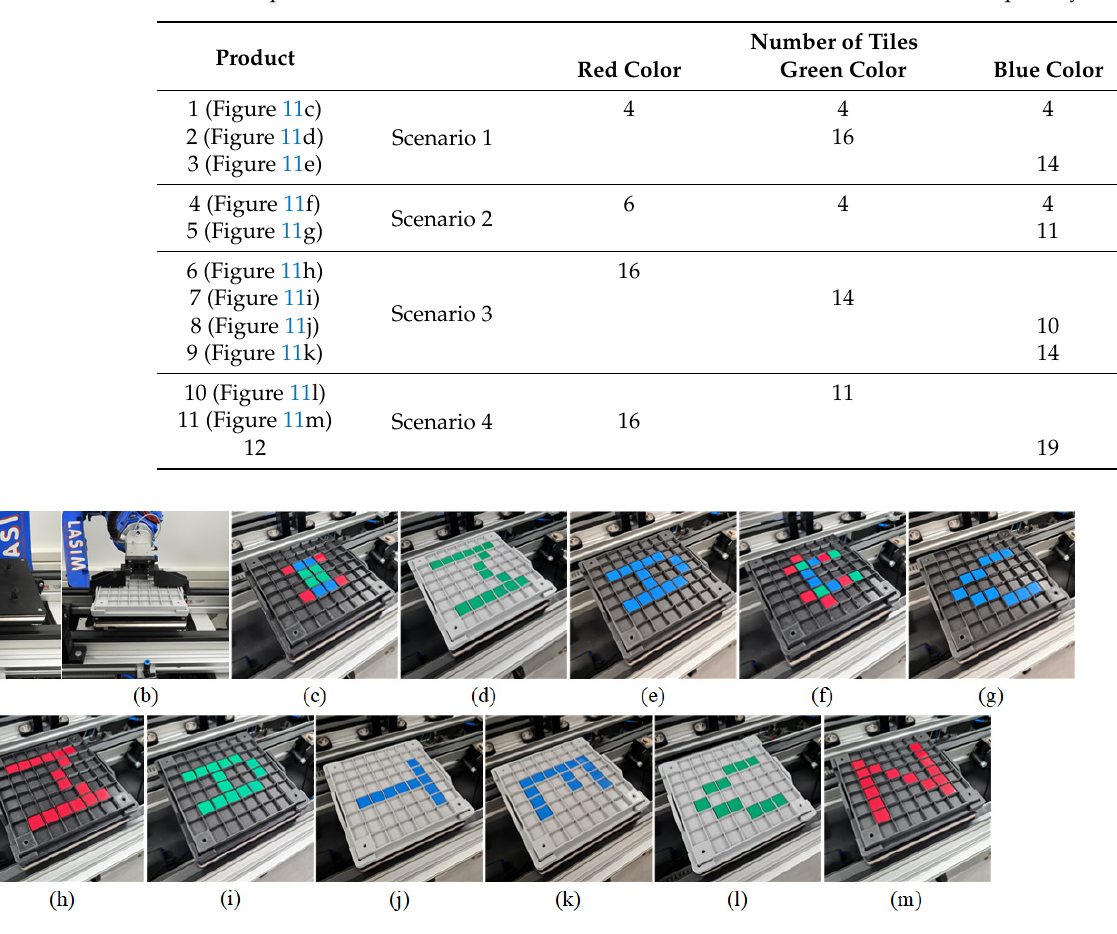
Figure 11. ( a ) Empty pallet; ( b ) Pallet with a base part; ( c ) Product 1; ( d ) Product 2; ( e ) Product 3; ( f ) Product 4; ( g ) Product